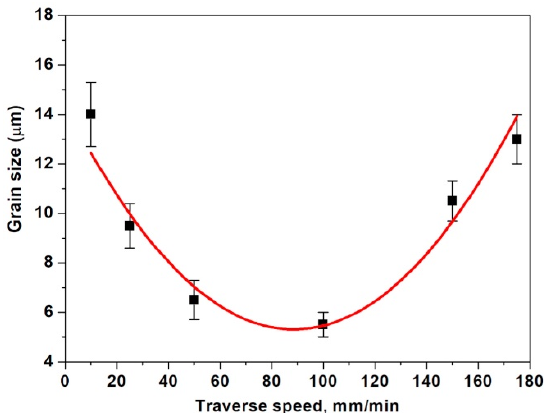
Figure 6. The relationship of grain size and traverse speed for FSP 2507 steel reprinted with permission from Mishra et al., 2018 [65].